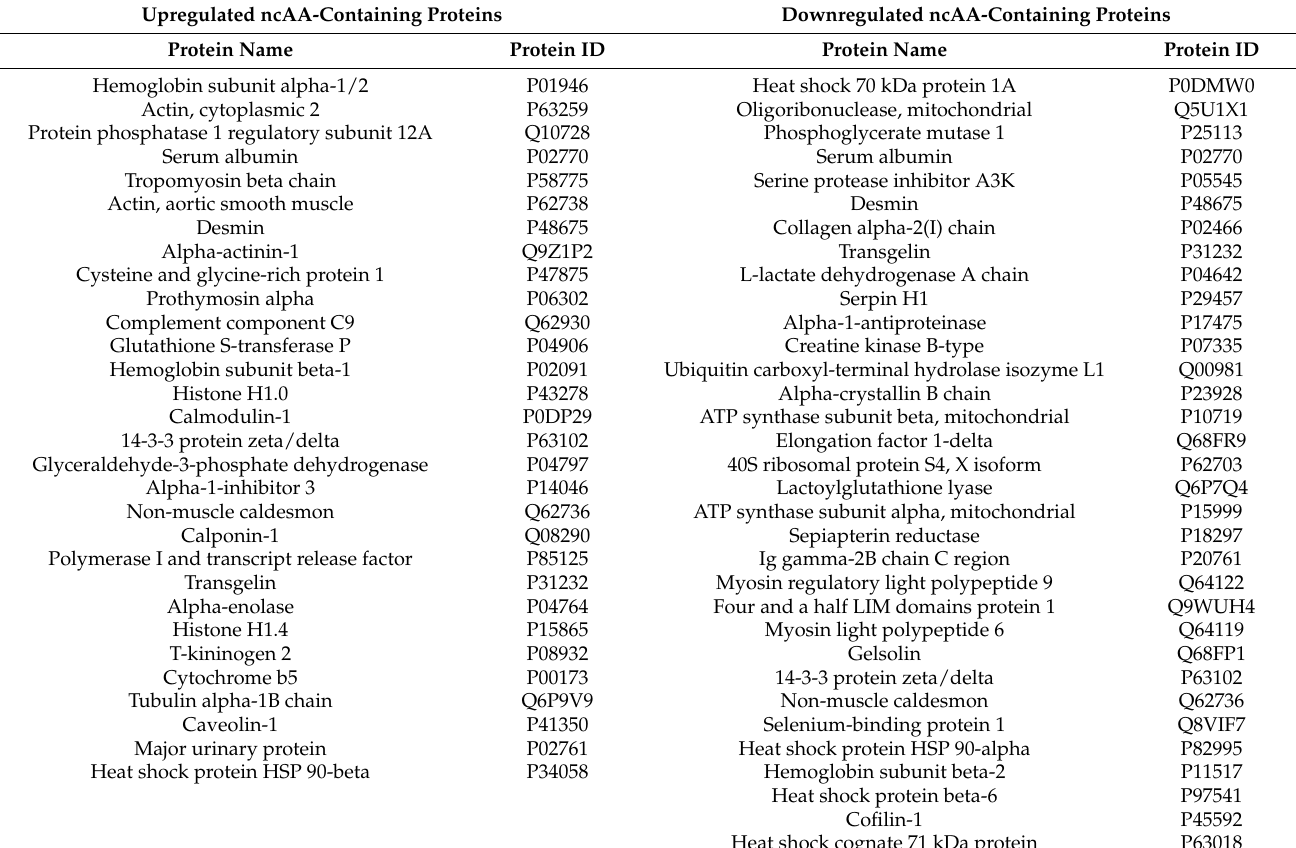
Table 2. Ischemia-associated ncAA-containing proteins (R 2 > 0.5, ratio > 2-fold, p < 0.05). Upregulated ncAA-Containing Proteins